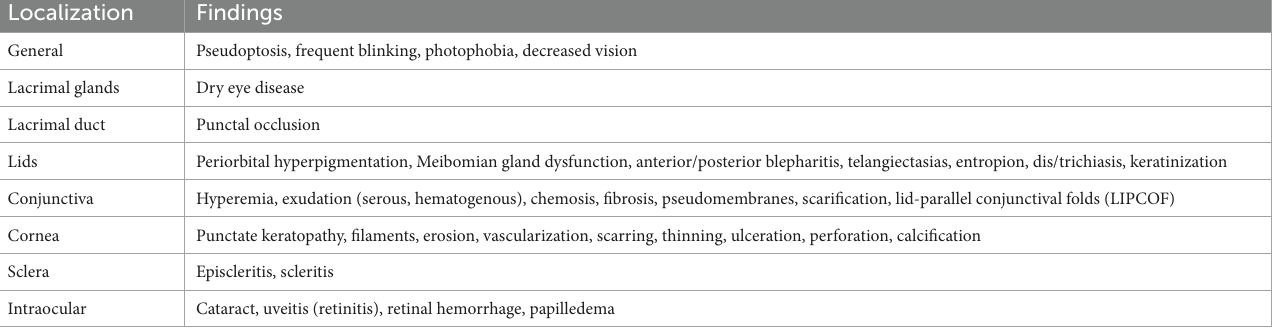
TABLE 2 Ophthalmological findings in ocular GVHD patients.